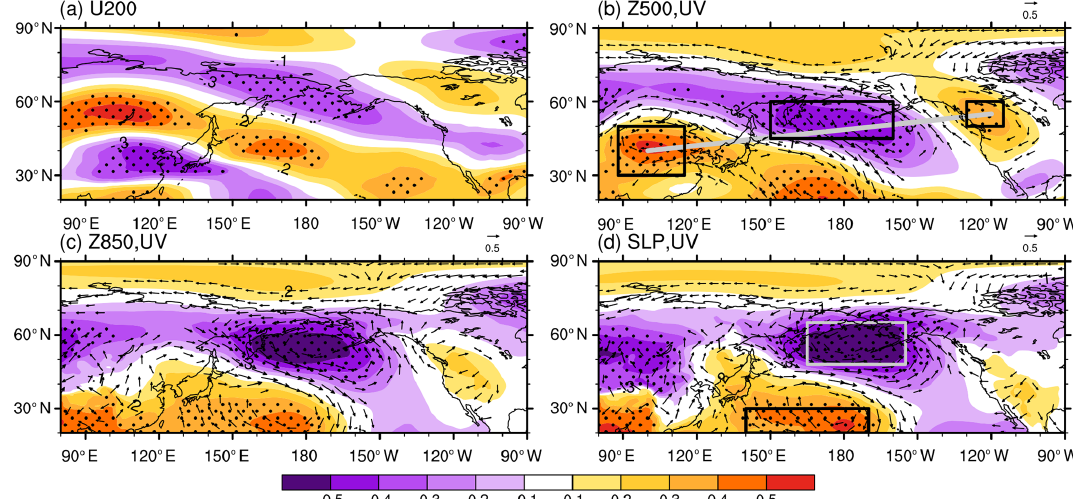
Figure 12. The CC between the November SST BA and (a) zonal wind at 200hPa, (b) wind (arrow), geopotential height (shading) at 500hPa, (c) wind (arrow), geopotential height (shading) at 850hPa, (d) surface wind (arrow) and SLP (shading) in December–January from 1979 to 2015. The black dots indicate that the CCs exceeded the 95% confidence level ( t test). The linear trend was removed. The black boxes in panel (b) represent the three anomalous centers at 500hPa, and the gray and black boxes in panel (d) represent the negative and positive anomalous centers.